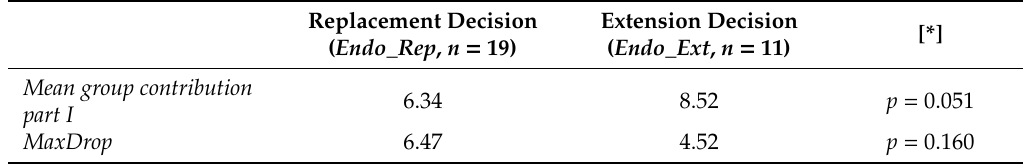
Table 4. Average of mean group contribution and MaxDrop in part I by decision.